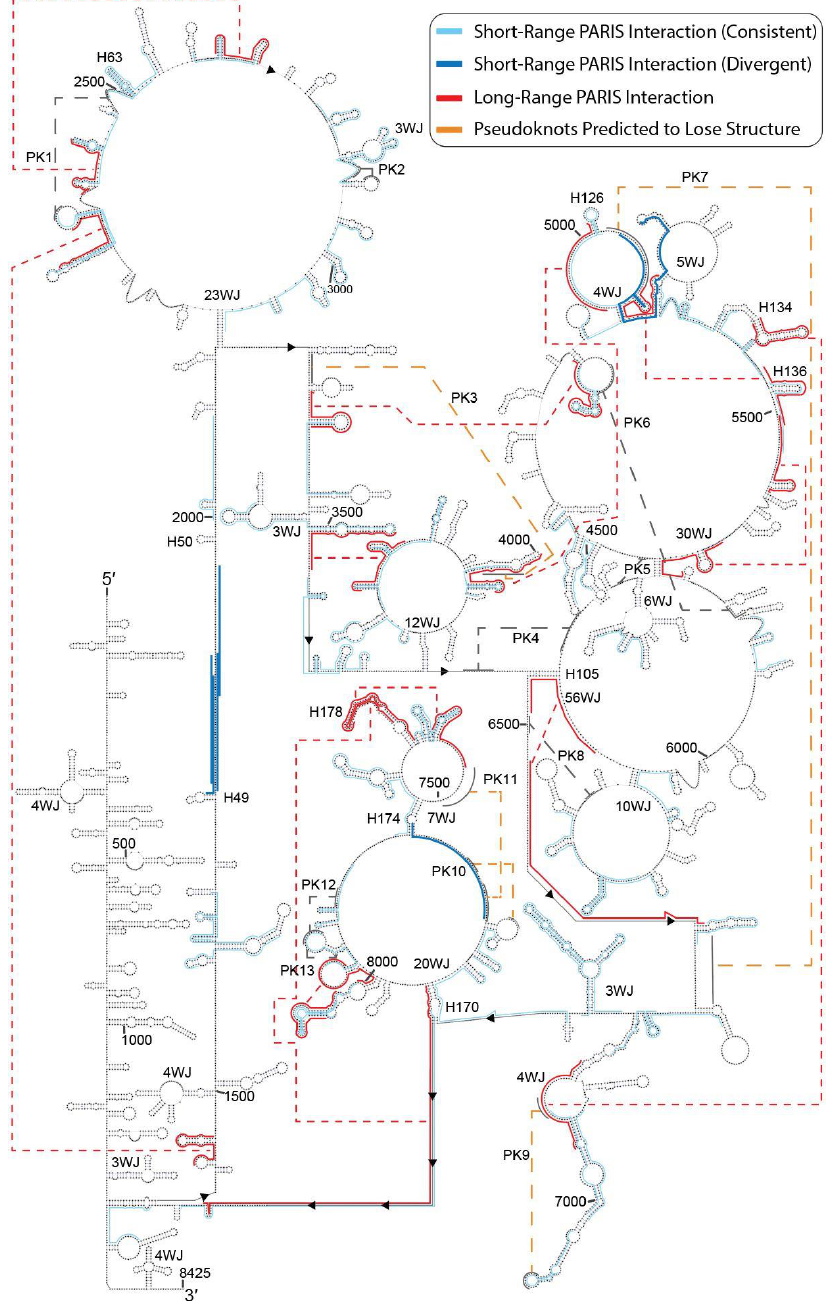
Figure 6 . Map of HeLa PARIS data onto the MALAT1 secondary structural model. Short-range (or local) PARIS interactions are depicted with 25 nucleotides flanking the datapoint. Short-range PARIS interactions diverging from the model are dark blue lines, whereas those that are consistent with the consensus model are light blue lines. Long-range PARIS interactions diverging from the model are depicted as red lines and show 50 nucleotides flanking the datapoints. All datapoint coordinates are in Supplemental Table S2. PKs expected-to-be-lost are depicted with dashed orange lines. Labels for secondary structures correspond to those established for the working noncancerous MALAT1 model [15].